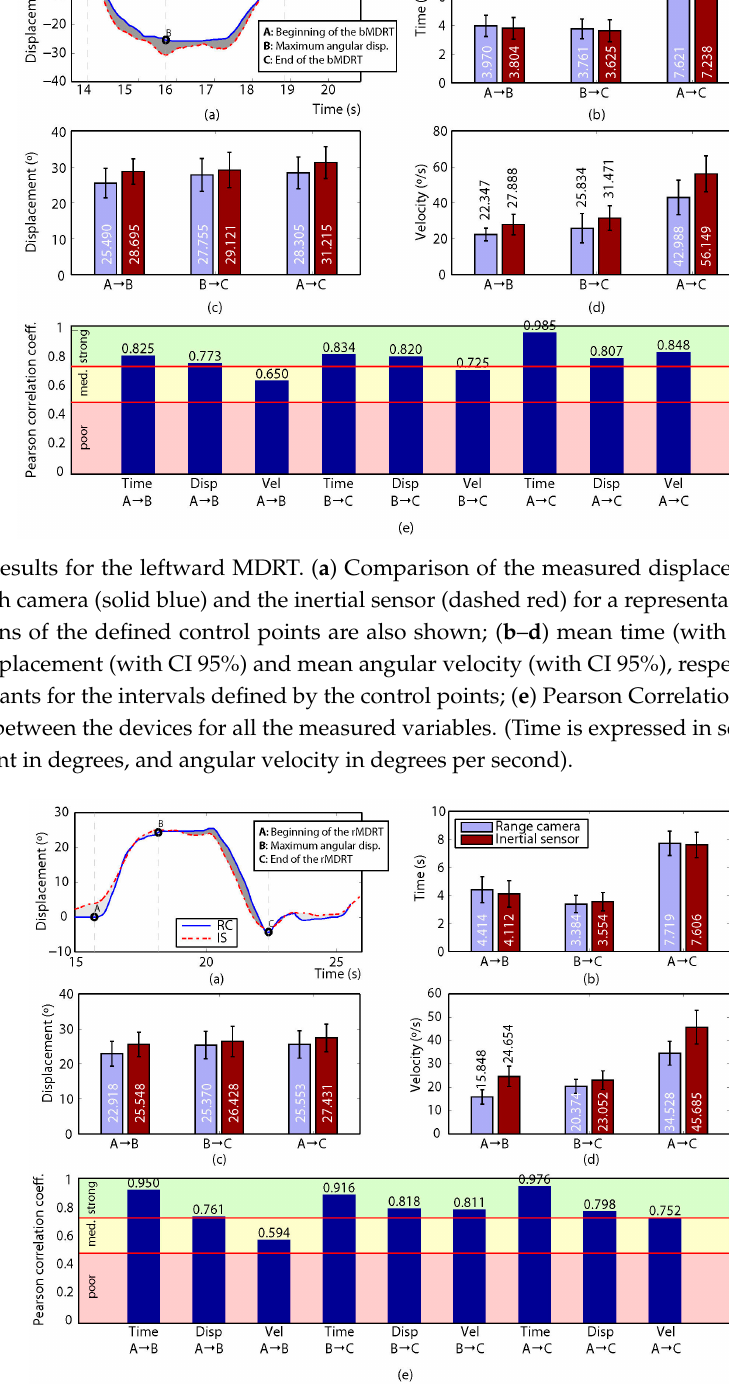
Figure 6. Results for the rightward MDRT. ( a ) Comparison of the measured displacement provided by the depth camera (solid blue) and the inertial sensor (dashed red) for a representative participant. The positions of the defined control points are also shown; ( b – d ) mean time (with CI 95%), mean angular displacement (with CI 95%) and mean angular velocity (with CI 95%), respectively, over all the participants for the intervals defined by the control points; ( e ) Pearson Correlation Coefficient (r) (p < 0.005) between the devices for all the measured variables. (Time is expressed in seconds, angular displacement in degrees, and angular velocity in degrees per second).